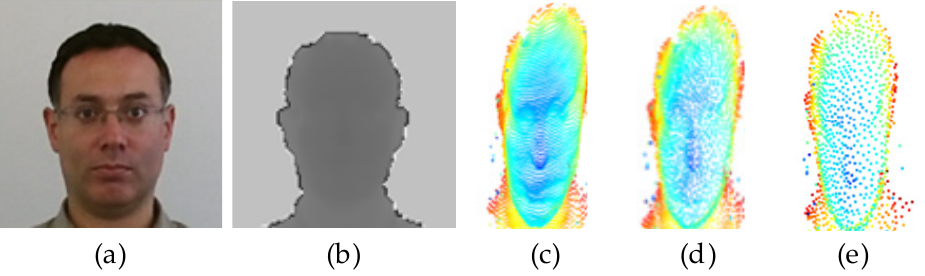
Figure 8. Examples of different input numbers of points, where ( a , b ) are corresponding RGB images and depth maps, and ( c – e ) represent input point clouds with 4096, 2048, and 1024 points, respectively. Table 3. Results of the different input numbers of points on the Biwi Kinect Head Pose dataset.